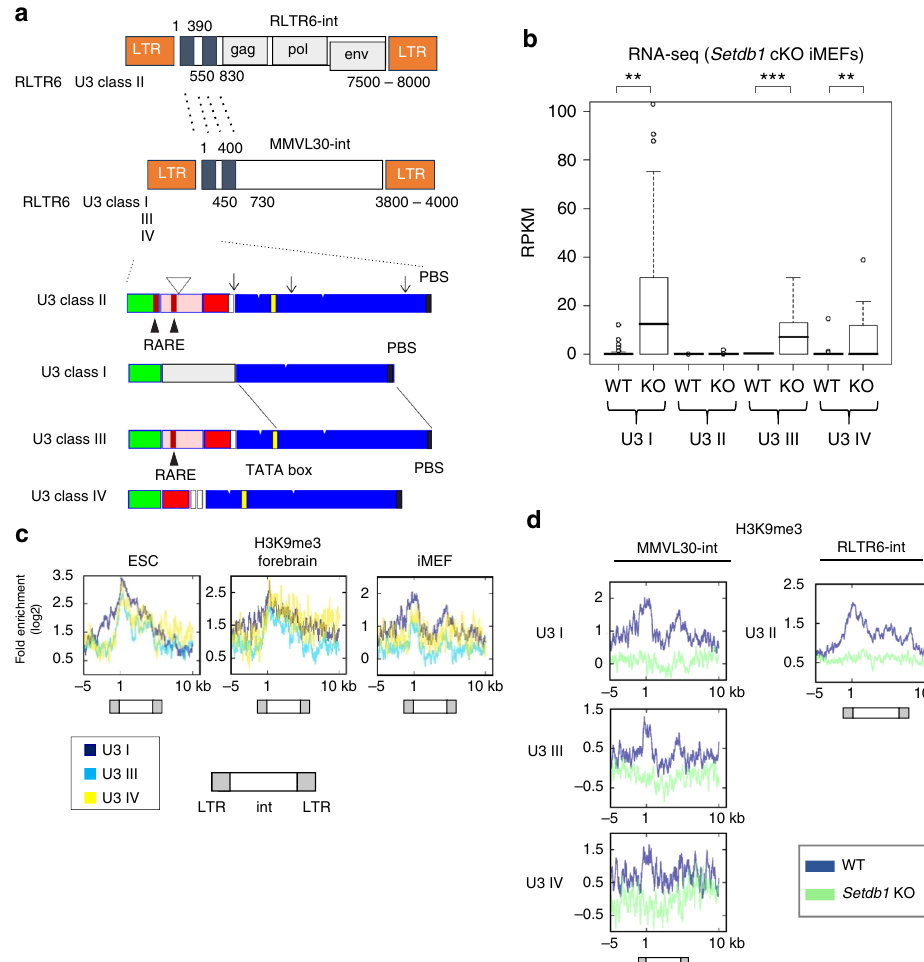
Fig. 2 MMVL30 families are derepressed in Setdb1 KO iMEFs. a Schematic structures of VL30 families. Blue boxes indicate highly homologous sequences between MMVL30-int and RLTR6-int. High magni fi cation of LTR regions of U3 classes. Color boxes indicate highly homologous sequence among LTRs. White arrowhead and arrow indicate unique insertion and mutation in class II, respectively. Black arrowhead indicates RARE sites. b Expression of VL30 U3 classes in Setdb1 KO iMEFs. Boxplots show that expression of VL30 U3 classes in Setdb1 KO iMEFs (day 5 after 4OHT treatment (KO) or no treatment (WT)). RNA-seq reads overlapping each VL30 loci are counted and normalized using the length of the locus and million mapped reads (RPKM). U3 I (71 loci), U3 II (189 loci), U3 III (66 loci), and U3 IV (26 loci). **0.0005 < P < 0.005, *** P < 0.0005, Student ’ s t -test. c NGS plots of H3K9me3 ChIP-seq data at genomic VL30 loci (RLTR6_Mm - MMVL30-int) of ESCs, E14.5 forebrain cells and iMEFs. MMVL30-int with RLTR6_Mm U3 I (36), with U3 III (40) and with U3 IV (10). The number inside of parenthesis indicates the number of individual each element analyzed. LTRs are aligned and MMVL30-int starts from position 1. H3K9me3 intensity pro fi les are shown with dark blue line (U3 I), light blue one (U3 III), and yellow one (U3 IV). Positions of LTRs and int are indicated below the plots. d NGS plots of H3K9me3 ChIP-seq data at genomic “ RLTR6_Mm - MMVL30-int ” and “ RLTR6_Mm - RLTR6-int ” loci in Setdb1 cKO iMEFs (day7 after 4OHT treatment (KO) and no treatment (WT)). H3K9me3 fold enrichments (log2) are shown with dark blue line (WT) and light blue one